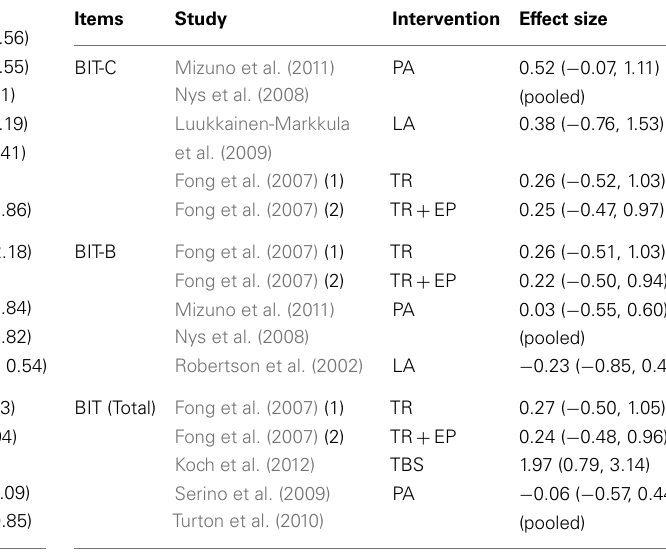
Table 4 | Long-lasting effect size of each rehabilitation intervention.